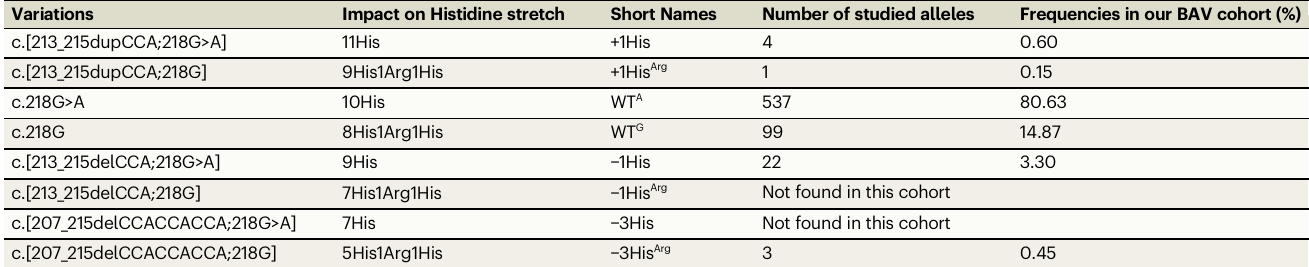
Table 2 | Distribution of HOXA1 histidine stretch variations in our BAV population ( n = 333 Index cases)